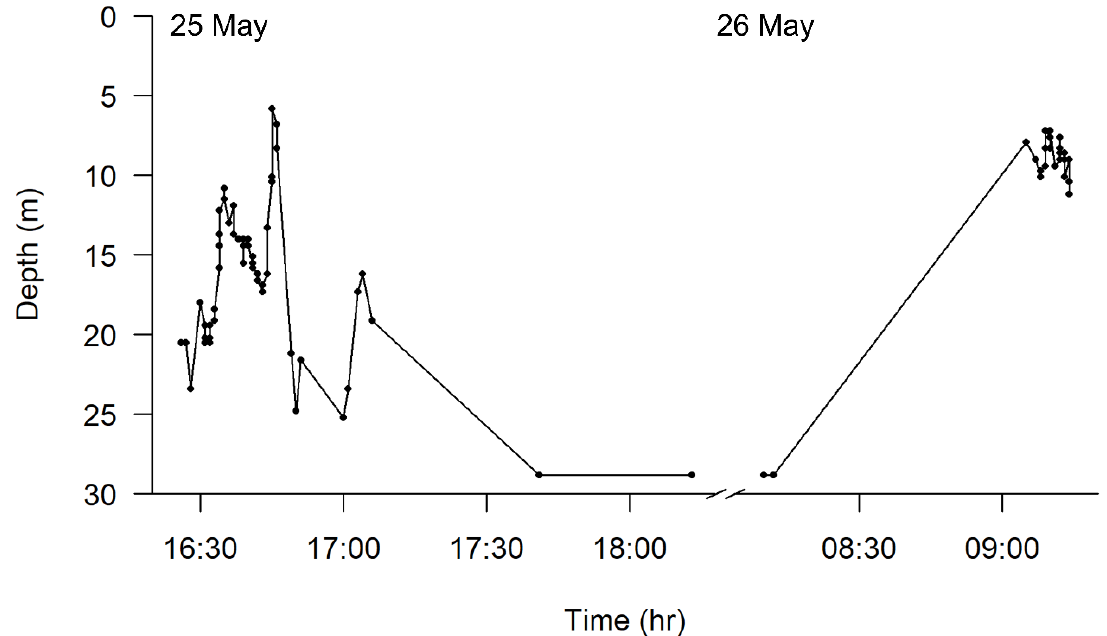
Figure 5. Depth profile of one Bagarius yarrelli monitored for approximately 17 h at the Pha Pra Thai receiver (PPT) in the Mekong River, Thailand. The maximum depth of the river at this location is not shown on the graph because the maximum depth is not known. Forty-four data points are obscured by the break in the x-axis: all except two have the same value as the two points before and after the break (28.8 m); the other two points are 29.2 m.